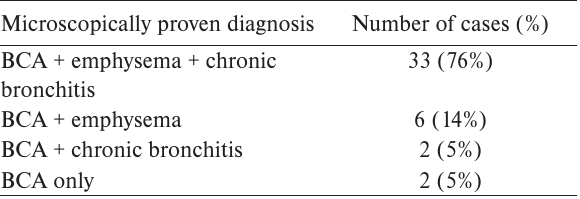
Table 5. Combination of lung cancer, emphysema and chronic